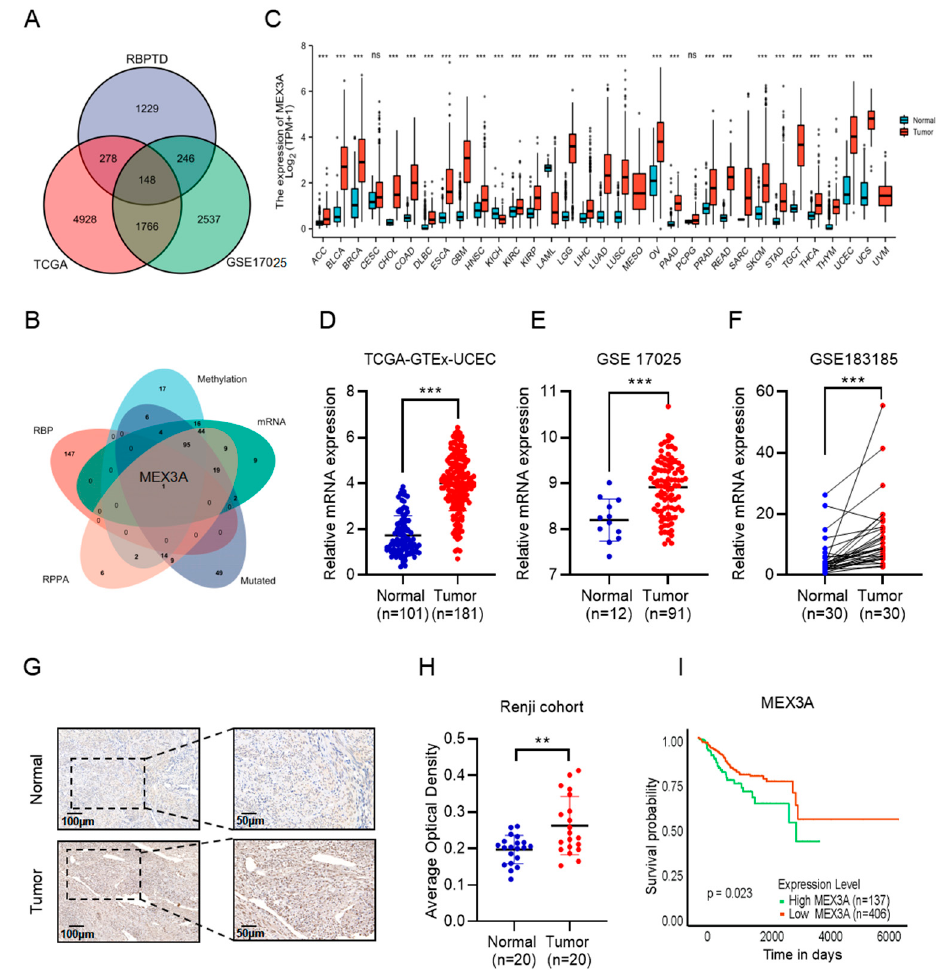
Figure 1. MEX3A is upregulated in EC and correlated with a poor prognosis in patients. ( A ) In total, 148 RBPs were identified as being differentially expressed in EC. ( B ) MEX3A was the only RBP identified by intersection analysis in EC. ( C ) Expression of MEX3A in 33 different tumors and corresponding normal tissues according to TCGA. ( D – F ) MEX3A expression in EC tissues and normal tissues in the TCGA-GTEx-UCEC, GSE17025, and GSE183185 datasets. ( G ) Immunohistochemistry stain of MEX3A expression in EC and normal tissues. Scale bars, 100 µ m, 200 µ m. ( H ) Immunohis- tochemical scoring of MEX3A expression based on images. AOD = IOD/area. ( I ) Kaplan–Meier analysis of the correlation between OS and the expression of MEX3A according to TCGA. ns p > 0.05, ** p < 0.01, *** p